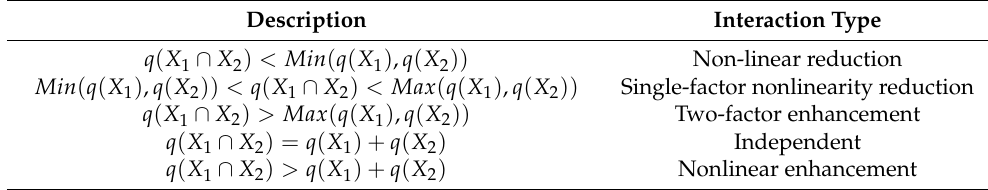
Table 2. Types of interaction between two independent variables and dependent